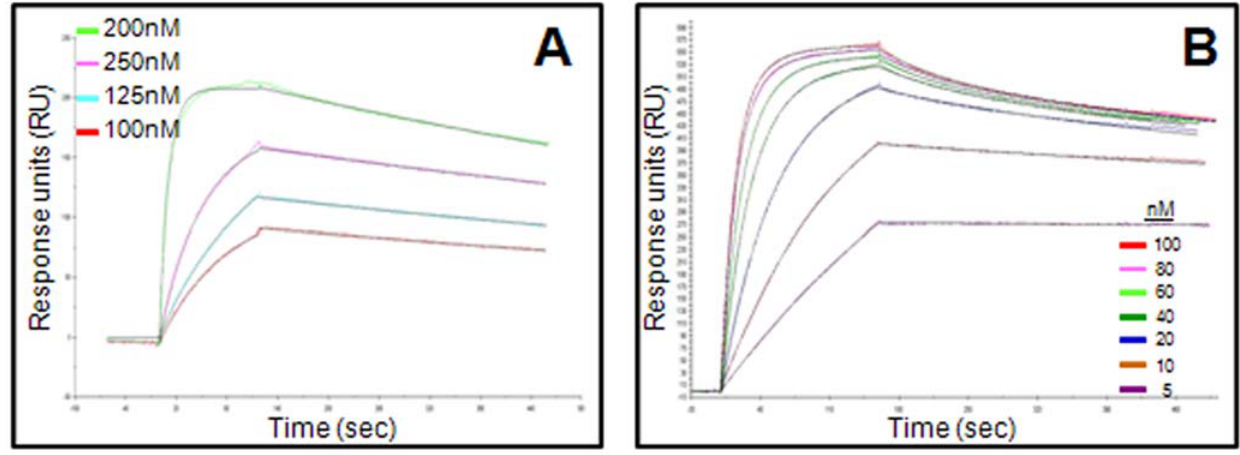
Figure 4. Kinetic analysis of mAb 29 and cAb 29 binding to PA. SPR sensograms obtained during injection of (A) 100–2000 nM of PA on anti- human captured cAb 29 ( , 300 RU), refers to the direct format; or (B) 5–100 nM of cAb 29 on immobilized PA ( , 900 RU), refers to the indirect format. Similar sensograms were obtained for the mAb 29 (results not shown).